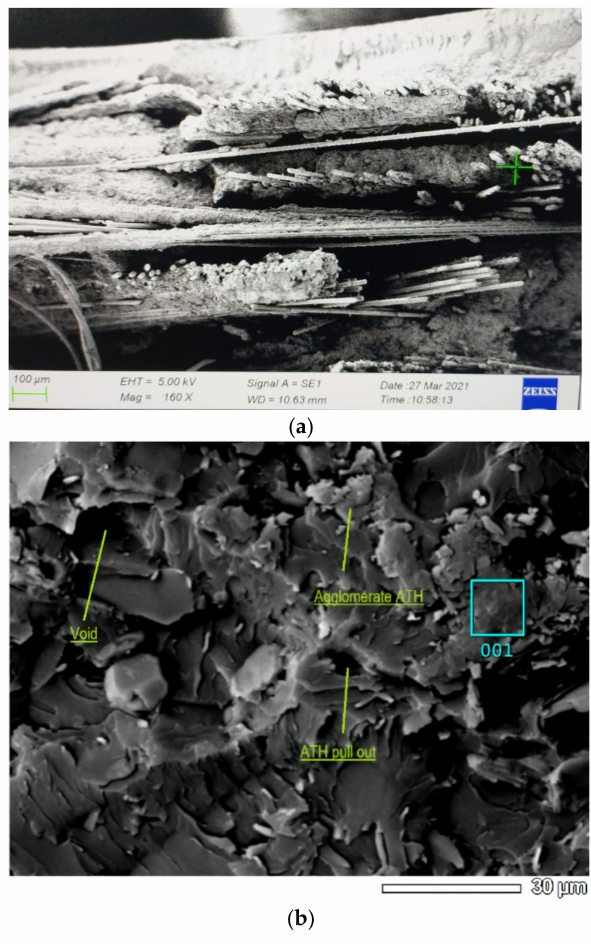
Figure 10. Micrograph result: ( a ) SEM of ATH distribution in UP resin; ( b ) SEM of stitch mat GFRP composite roof fracture.